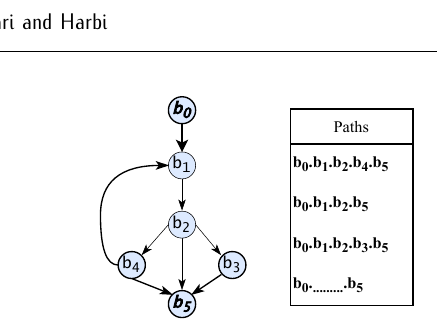
Figure 3. An Example Control Flow.